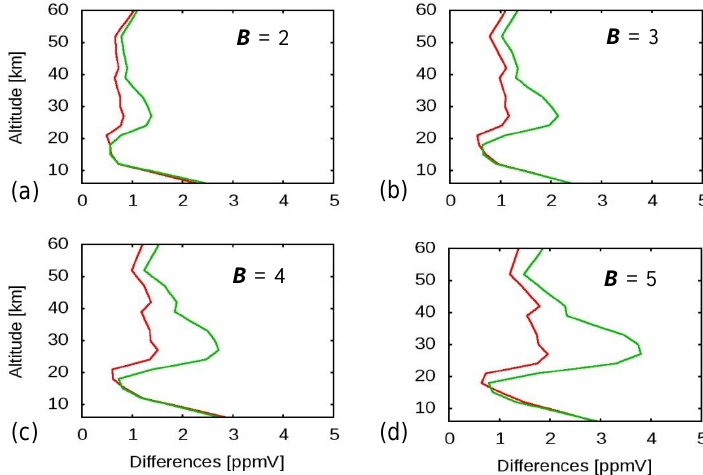
Figure 5. Red lines: overall plots for CO 2 retrievals in the case of B = 2 for P - and B = 1 for T -perturbations in Eq. (1); each panel contains the B value used for the CO 2 VMR perturbations. Green lines: same as red lines but excluding FIR MWs and H 2 O parameters from the retrieval set-up.